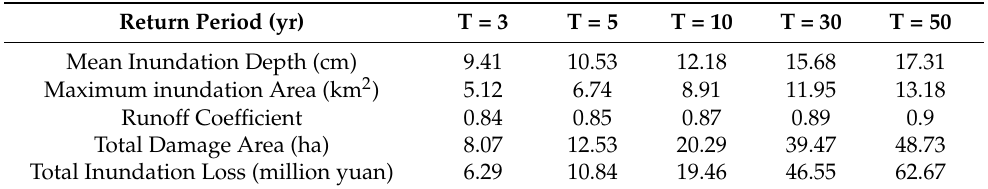
Table 4. The mean inundation depth, maximum inundation area, runoff coefficient, total damage area, and total inundation loss in different return